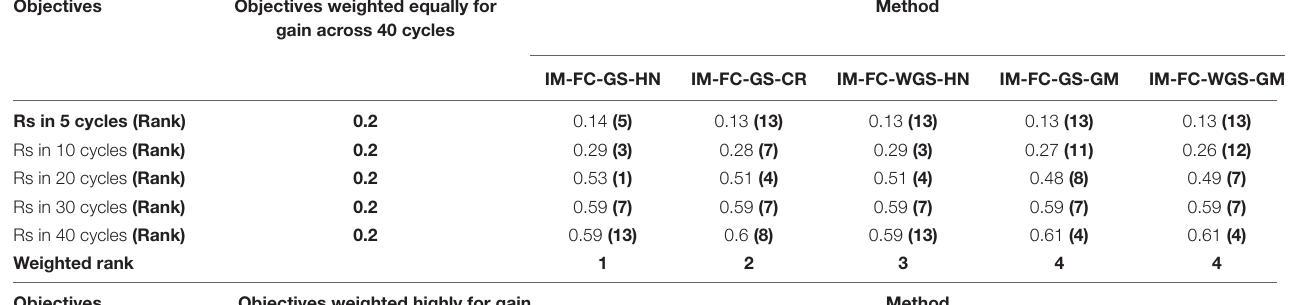
TABLE 2 | Trade-off table for strategies. Objectives Objectives weighted equally for gain across 40